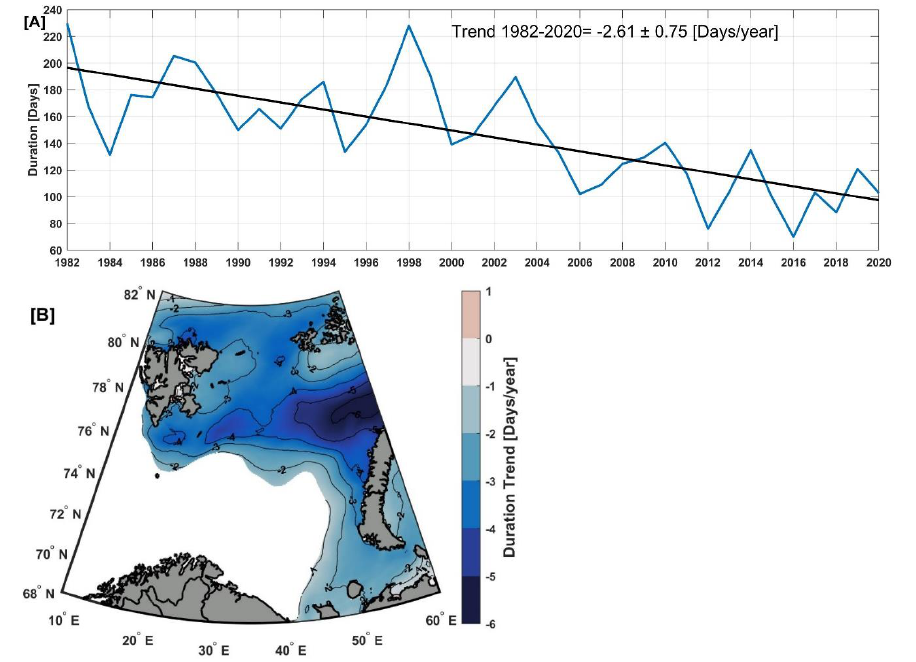
Figure 7. Average annual duration of the sea-ice season in the Barents Sea (( A ), blue line) and its temporal (( A ), black line) and spatial (( B ), shading) trends (in days/year) from 1982 to 2020.